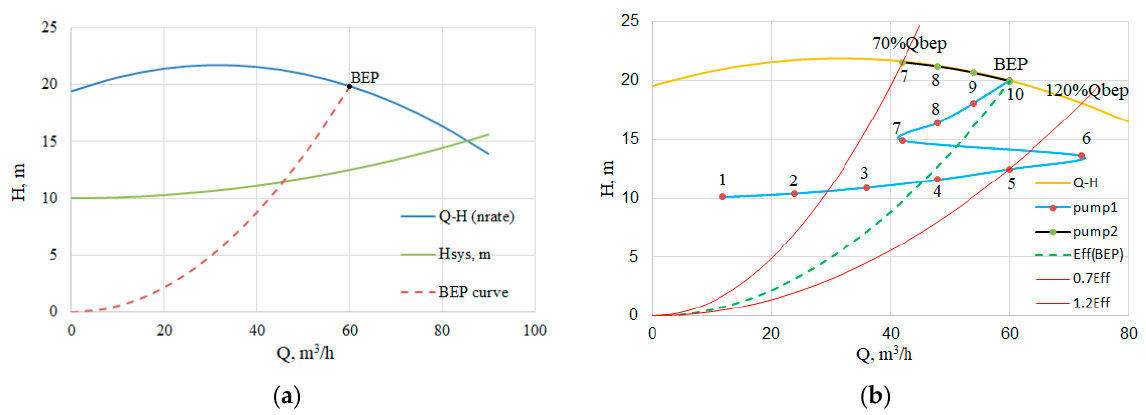
Figure 3. ( a ) Q-H characteristics of the pump, hydraulic system curve and BEP curve; ( b ) Q-H characteristics of the pump, boundaries of POR range, and operating points of the parallel pumps in the case of the minimum energy consumption control. Table 2. Pump system performances applying the minimum energy consumption control. Q , %